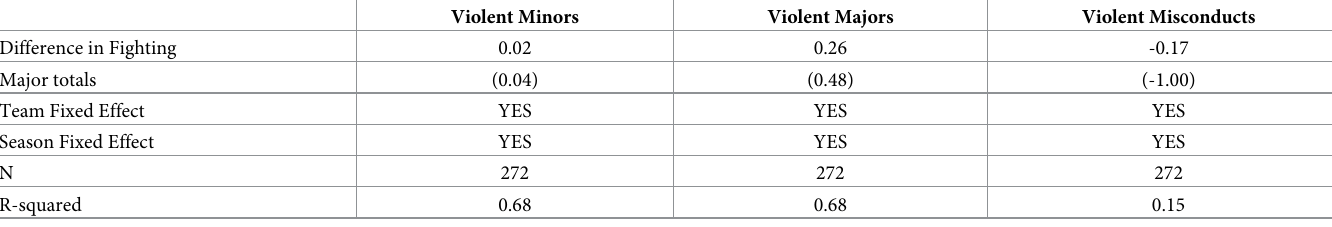
Table 2. Marginal effect of first half violent penalties against on difference in fighting majors from first to second